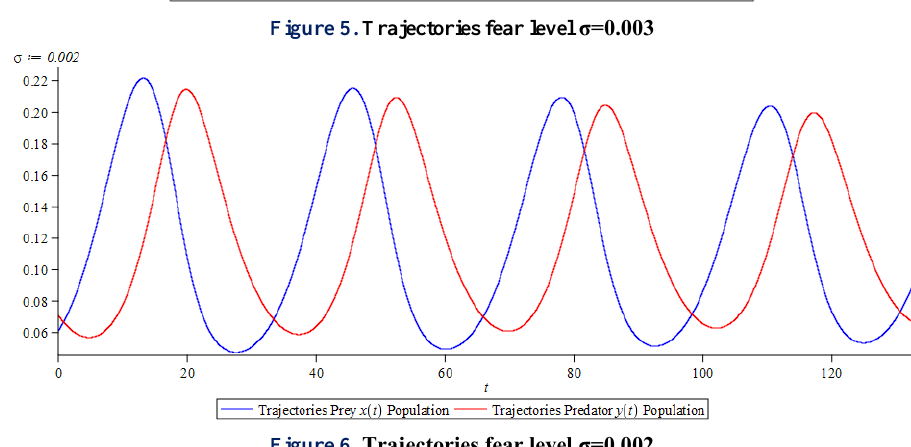
Figure 6. Trajectories fear level σ=0.002